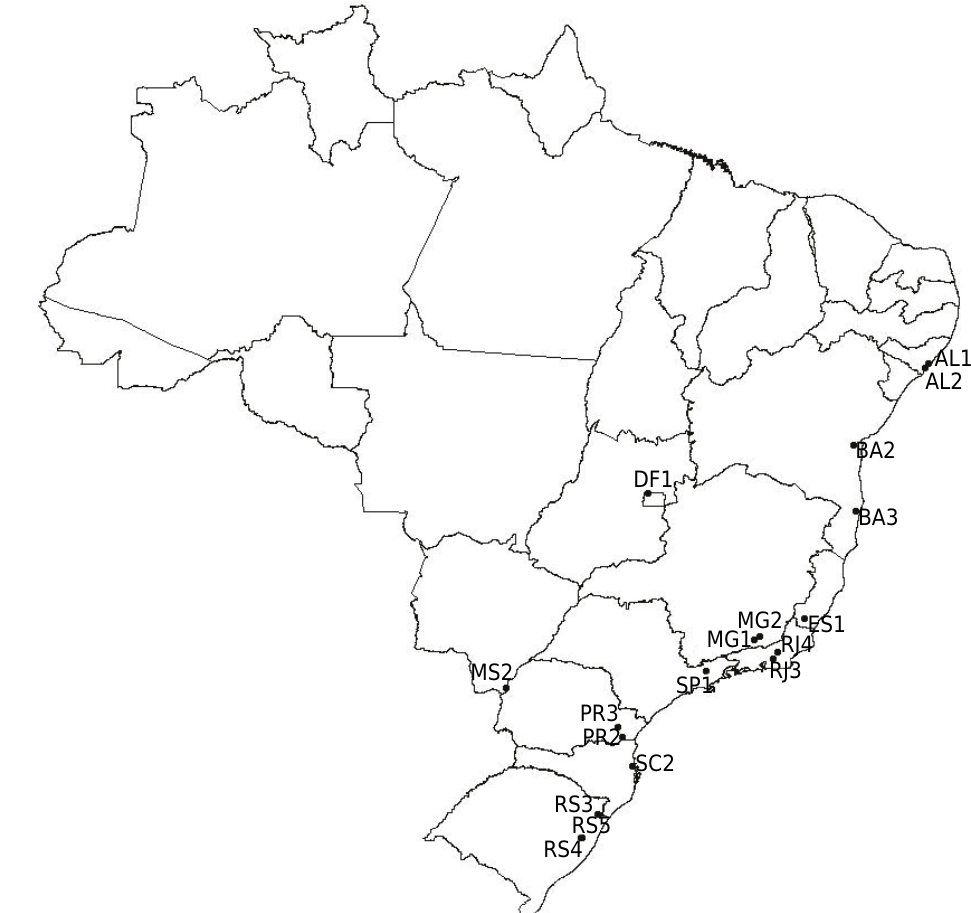
Figure 1. Distribution of Organosol profiles in Brazilian